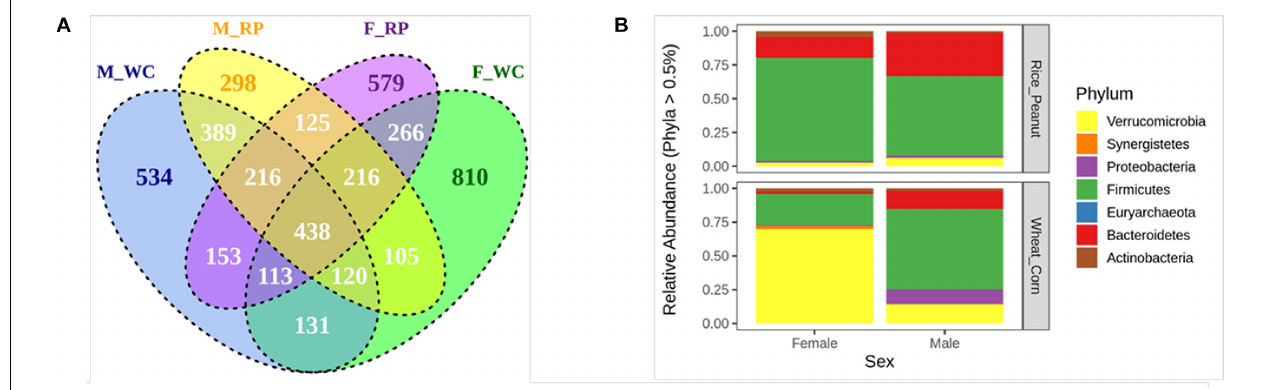
FIGURE 2 | (A) The venn diagram of the OTUs in all fecal samples among groups. (B) Relative abundance of the microbiota communities at the phylum level for female and male Great Bustards with different diets. OTUs accounting for less than 0.5% of therelative abundance were pruned out prior to plotting. F_RP: females with Rice_Peanut diet, M_RP: males with Rice_Peanut diet, F_WC: females with Wheat_Corn diet and M_WC: males with Wheat_Corn diet.